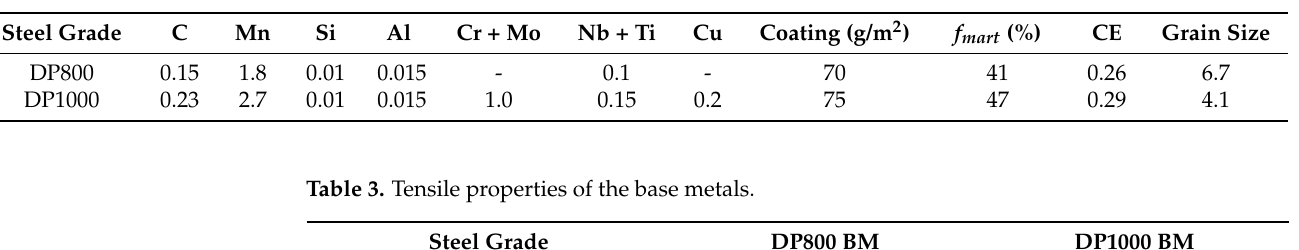
Table 2. Chemical composition, coating characteristics, and CE of the investigated DP800 and DP1000 steels.